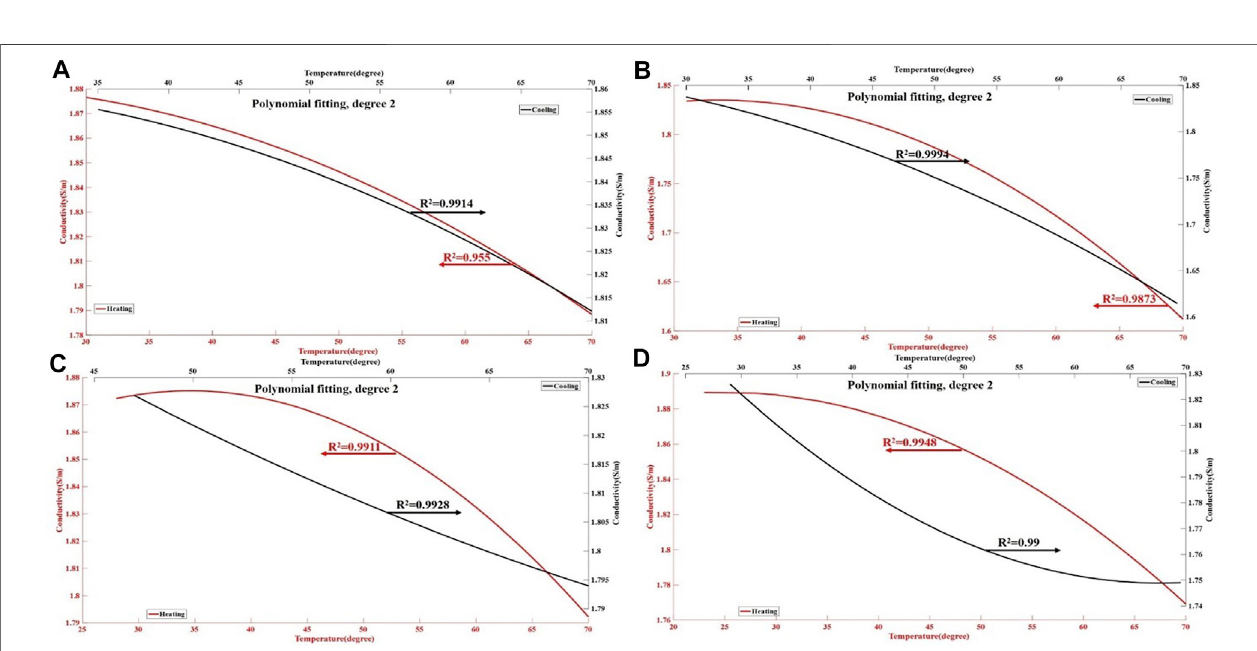
FIGURE 4 | Changes in the conductivity properties of ex vivo liver tissue during the heating and cooling process. The red lines in the fi gures (A – D) represent the polynomial curve fi tting of the conductivity of liver tissue during the heating process, with an R 2 values of 0.955 – 0.9948. The black line represents the polynomial curve fi tting of conductivity of liver tissue during the cooling process, with an R 2 of0.99 – 0.9994. The results show an almost nonlinear relationship between the conductivity of liver tissues and temperature.